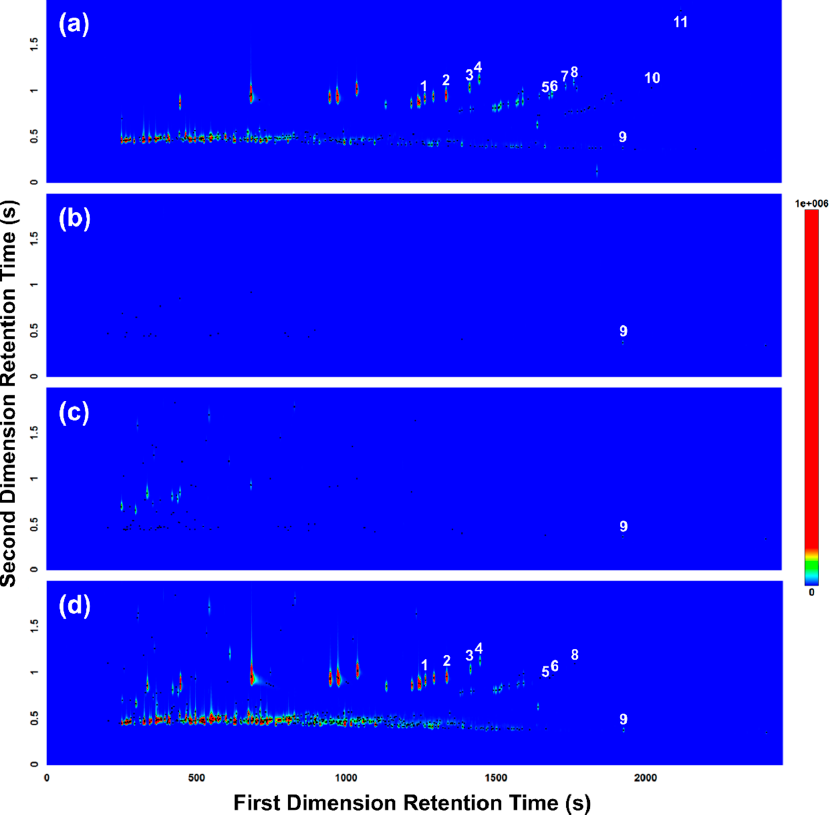
Figure 4. GC×GC-TOFMS TIC contour plots of headspace samples collected and analyzed from ( a ) reference gasoline; ( b ) body bag control; ( c ) pig burnt without gasoline; and ( d ) pig burnt with gasoline. Peak markers (represented by black dots) highlight each VOC detected. Numerals denote ASTM E1618-14 [24] gasoline target compounds detected: (1) 1,3,5-trimethylbenzene; (2) 1,2,4-trimethylbenzene; (3) 1,2,3-trimethylbenzene; (4) indane; (5) 1,2,4,5-tetramethylbenzene; (6) 1,2,3,5-tetramethylbenzene; (7) 5-methylindane; (8) 4-methylindane; (9) dodecane; (10) 4,7- dimethylindane; and (11)